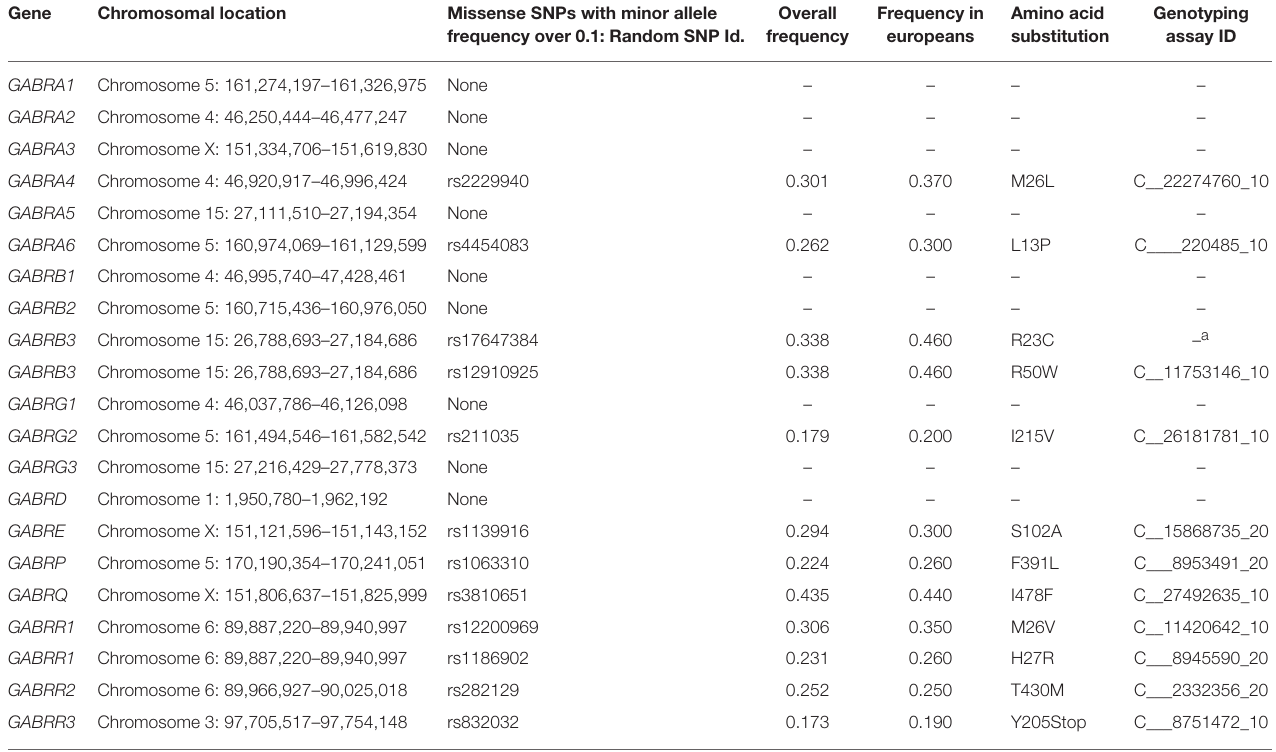
TABLE 1 | Common stop and missense SNPs in GABR genes and allele frequencies according the 1,000 genomes database.